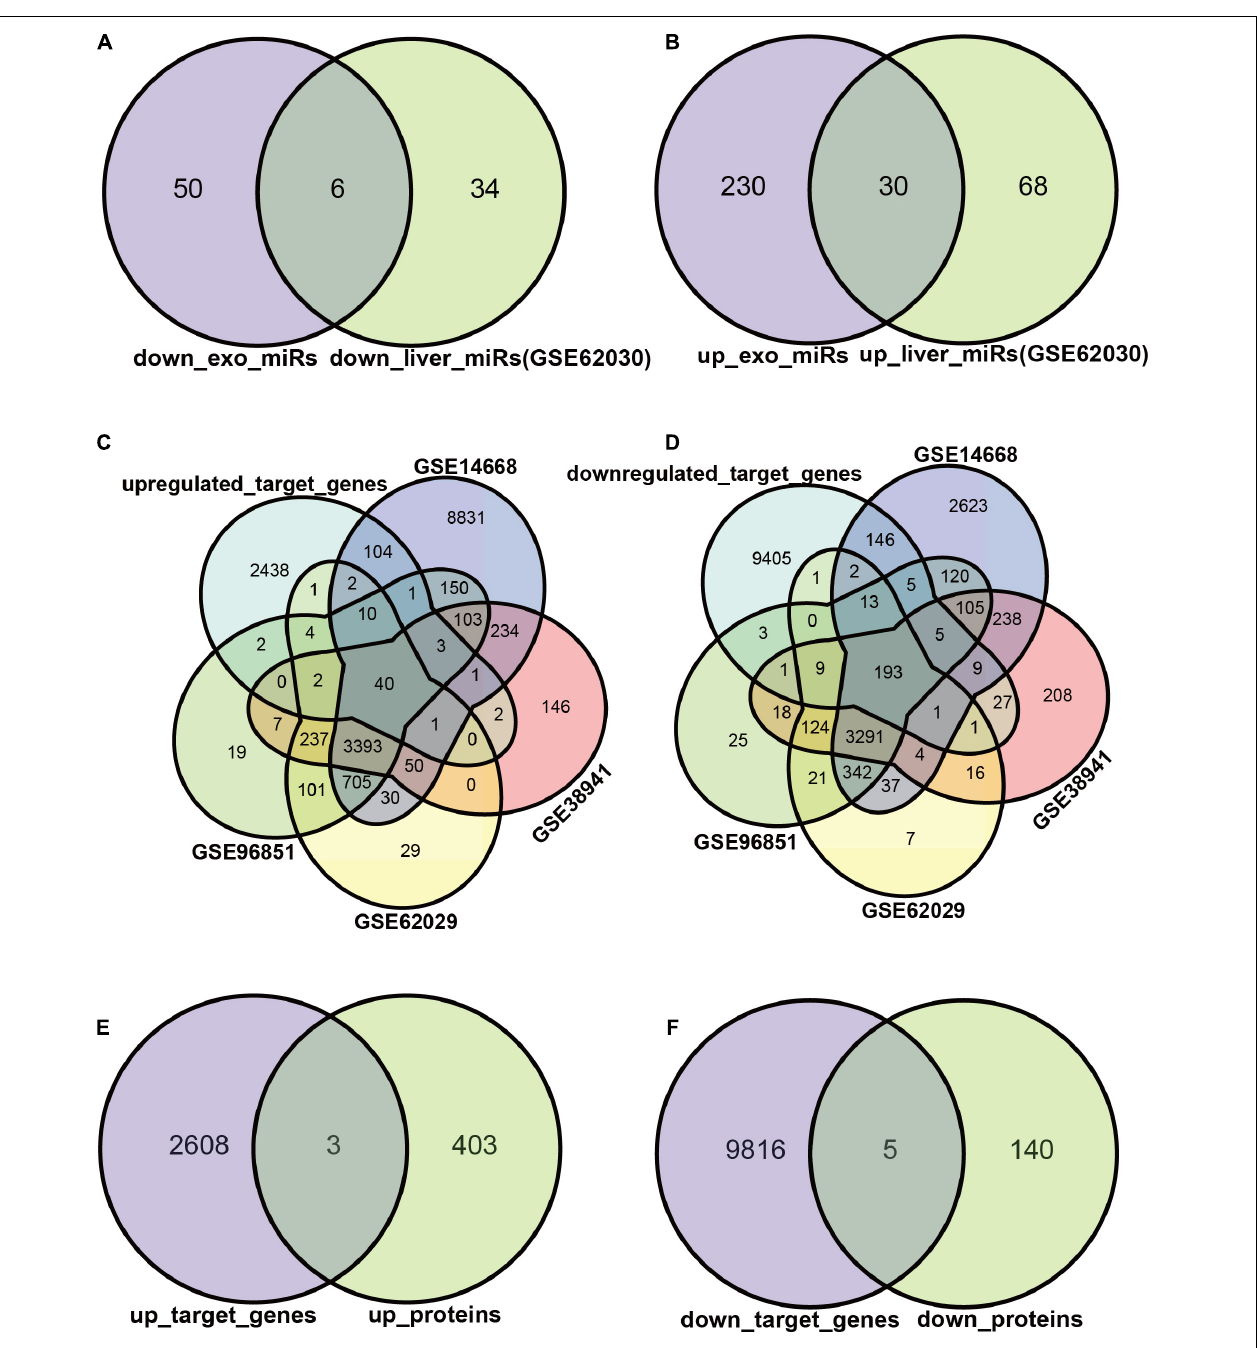
FIGURE 3 | Exosomal miRNAs targeting regulated DEGs. (A,B) Exosomal miRNAs with identical differential expression in ACLF liver samples were screened as candidate DEmiRs. The Venn diagram shows the number of up- vs. down-regulated miRNAs. The miRNA screening criteria used was |logFC| ≥ 1, p ≤ 0.05. (C,D) The number of DEmiRs targeting genes differentially expressed in the transcriptome. The transcriptome screening criteria was |logFC| ≥ 2, p ≤ 0.05. (E,F) The number of DEmiRs target genes that are differentially expressed in the proteome. DEmiRs: differentially expressed miRNAs.